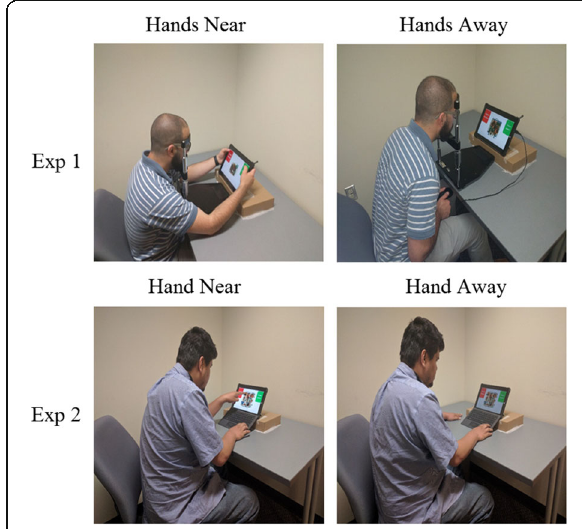
Fig. 3 Depiction of the experimental setup and hand positions for Experiments 1 and